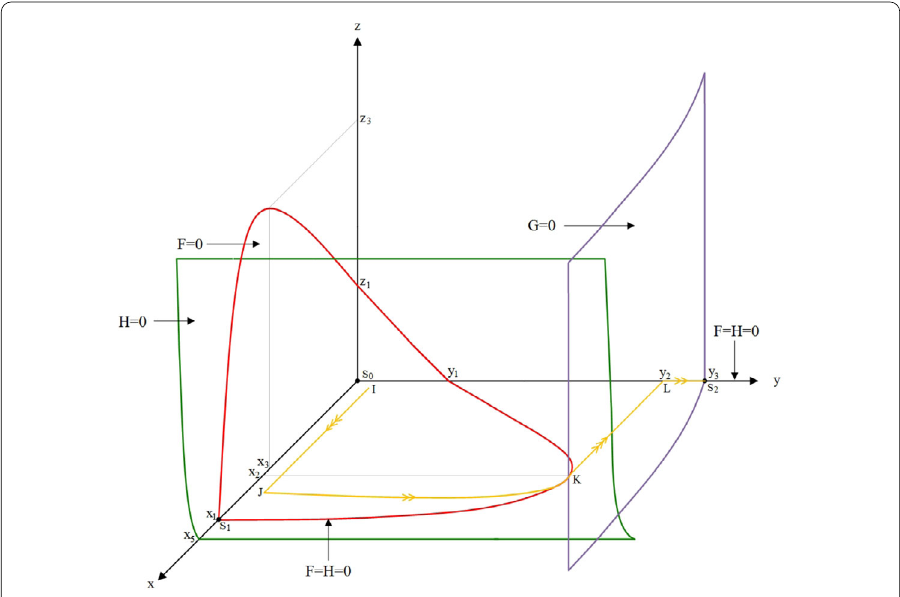
Figure 4 Shapes and relative positions of the manifolds where the parametric values of system of Eqs. (4)–(6) satisfy the conditions in Theorem